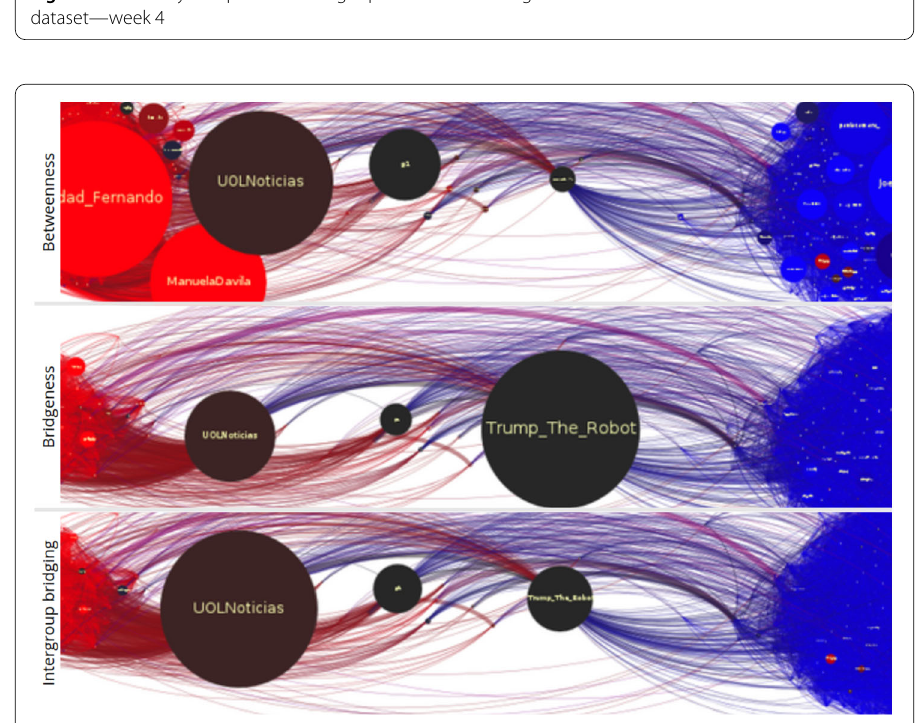
Figure 3 Comparison among centralities on week 4 in Brazil